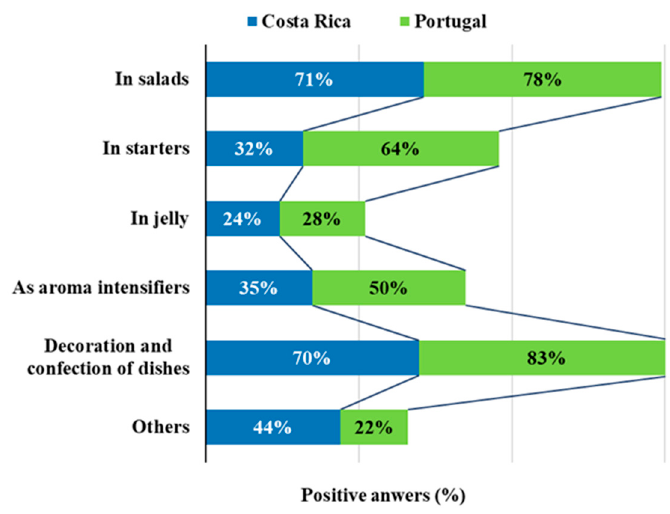
Figure 1. Possible ways in which the participants consumed edible flowers.